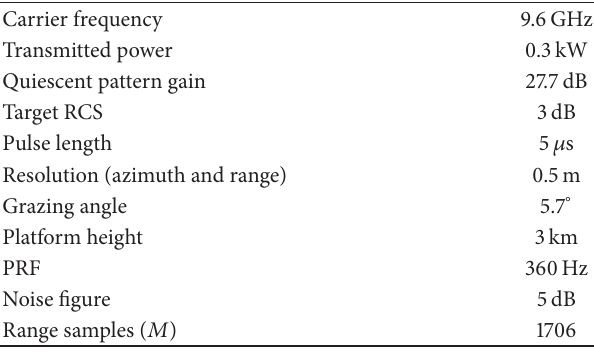
Figure 5: Focused image: noise and no jammer. Table 2: Estimated SINR values for the HTJS and